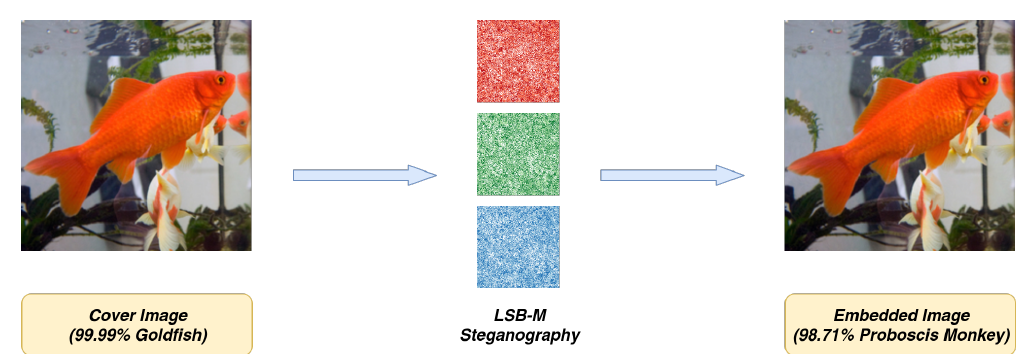
Figure 1. LSB-matching embedded image